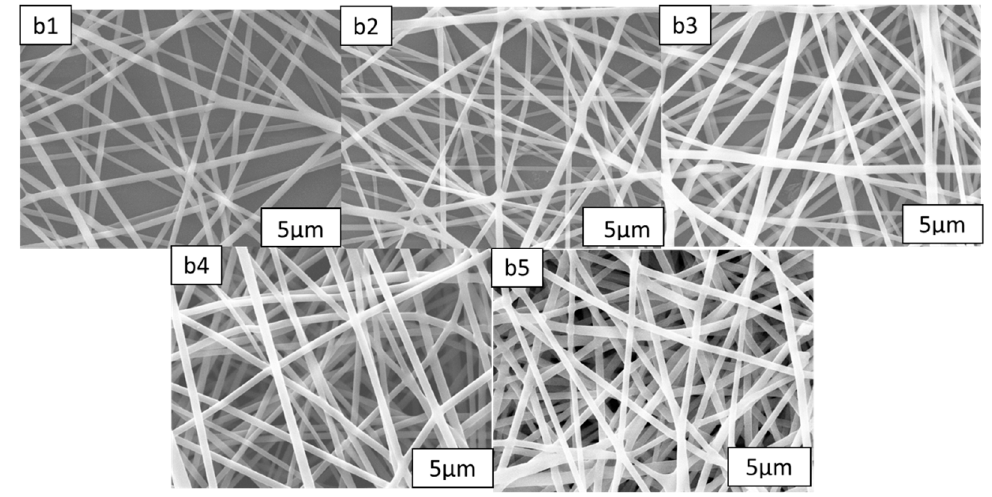
Figure 3. Polarized optical microscopy (POM) of nano fi bers of ( b1 – b5 ).